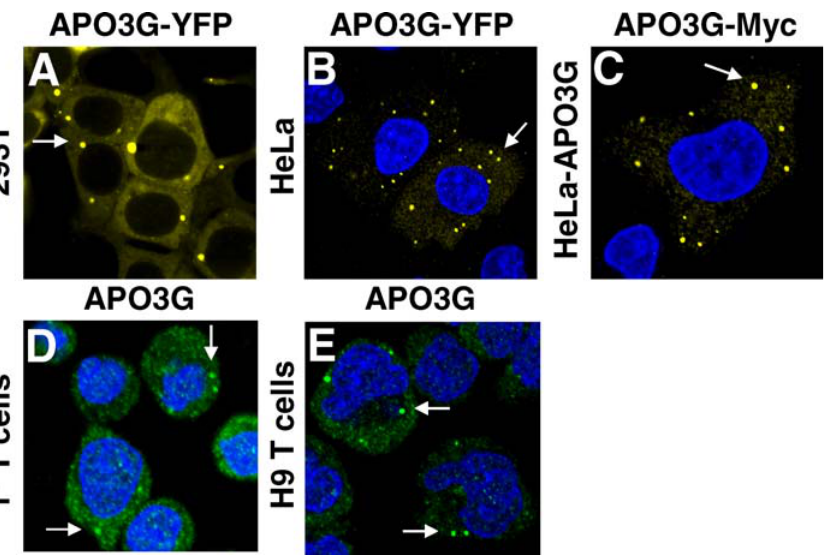
Figure 1. APOBEC3G Localizes to Cytoplasmic Bodies Subcellular localization images of living 293T cells transiently expressing APO3G-YFP (A), HeLa cells transiently expressing APO3G-YFP (B), HeLa-APO3G cells stably expressing APO3G-Myc (C), endogenous APOBEC3G in primary peripheral blood CD4 þ T cells (D), and endogenous APOBEC3G in H9 T lymphocytes (E). APO3G-YFP was detected by direct YFP fluorescence while APO3G-Myc and endogenous APOBEC3G were detected by indirect immunostaining, using antibodies against the c-Myc epitope and APOBEC3G, respectively. The cells were stained with Hoechst 33258 to visualize nuclei and the imaged were merged digitally. Cell type is noted to the left of each image and arrows point to cytoplasmic bodies. DOI: